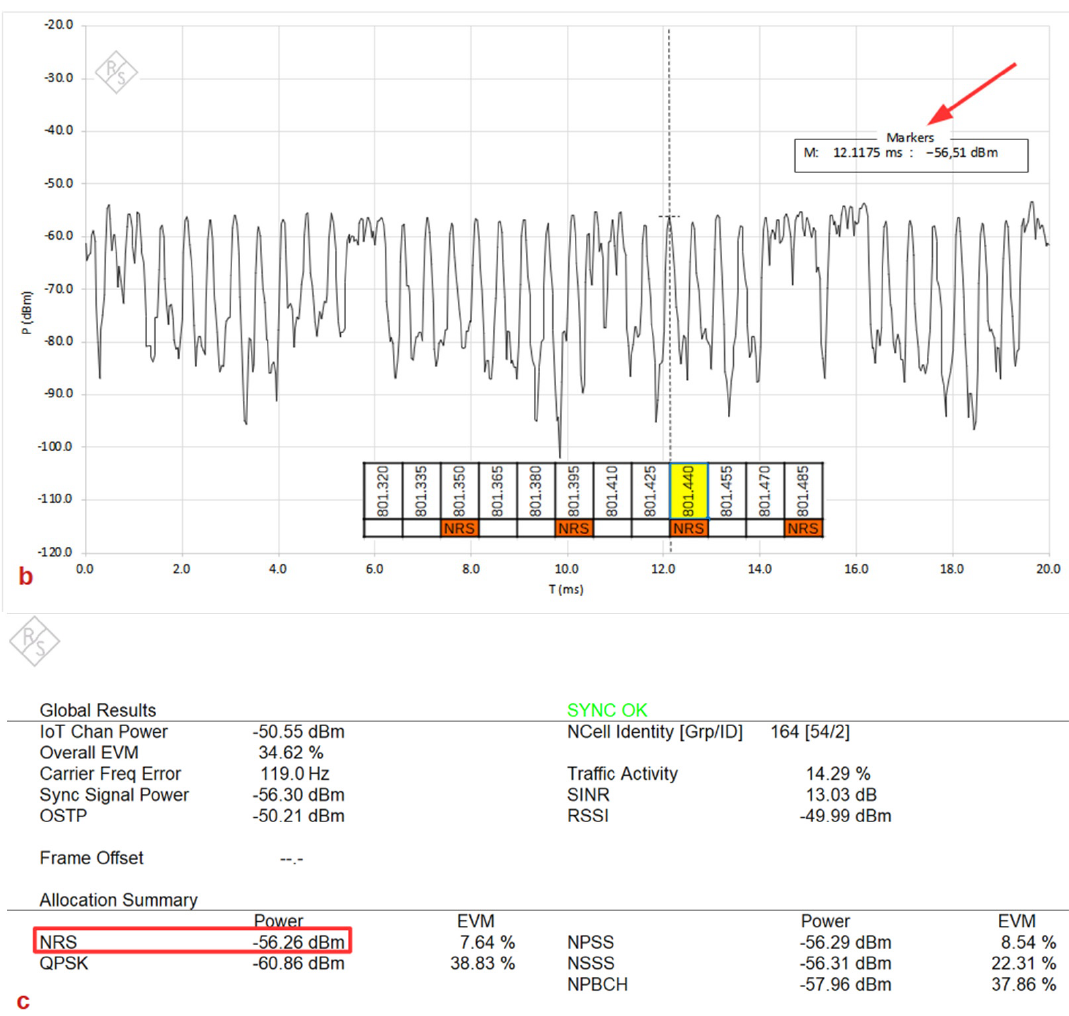
Figure 12. Example of comparison between measurements of received power values for NRS: in time domain ( a , b ) and code domain ( c